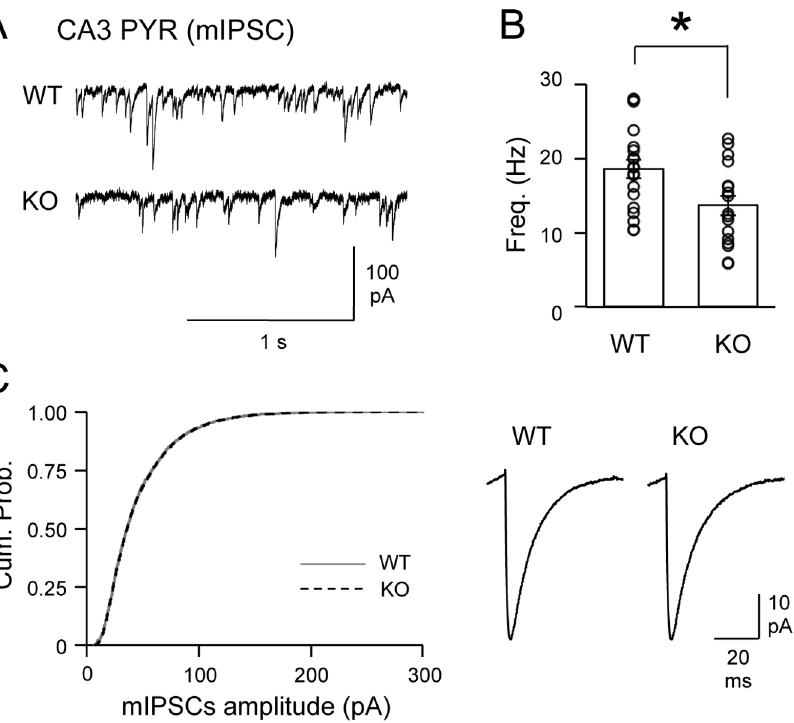
Figure 7. Reduced frequency of mIPSCs in CA3 PYRs of BACE1 KOs. (A) Representative mIPSC traces from CA3 PYRs in WTs and KOs. (B) BACE1 KOs showed significantly reduced mIPSC frequency in CA3 PYRs compared to WTs. Open circles are mIPSC frequency of individual cells *t test: P , 0.05. (C) Amplitude of mIPSCs in CA3 PYRs was not altered in KOs. Left: The cumulative probability curve of KO mIPSC amplitudes (black dotted line) superimposed with that of WT (gray solid line) (K–S test, P . 0.7). Right: Average mIPSC traces from PYRs of the two groups.